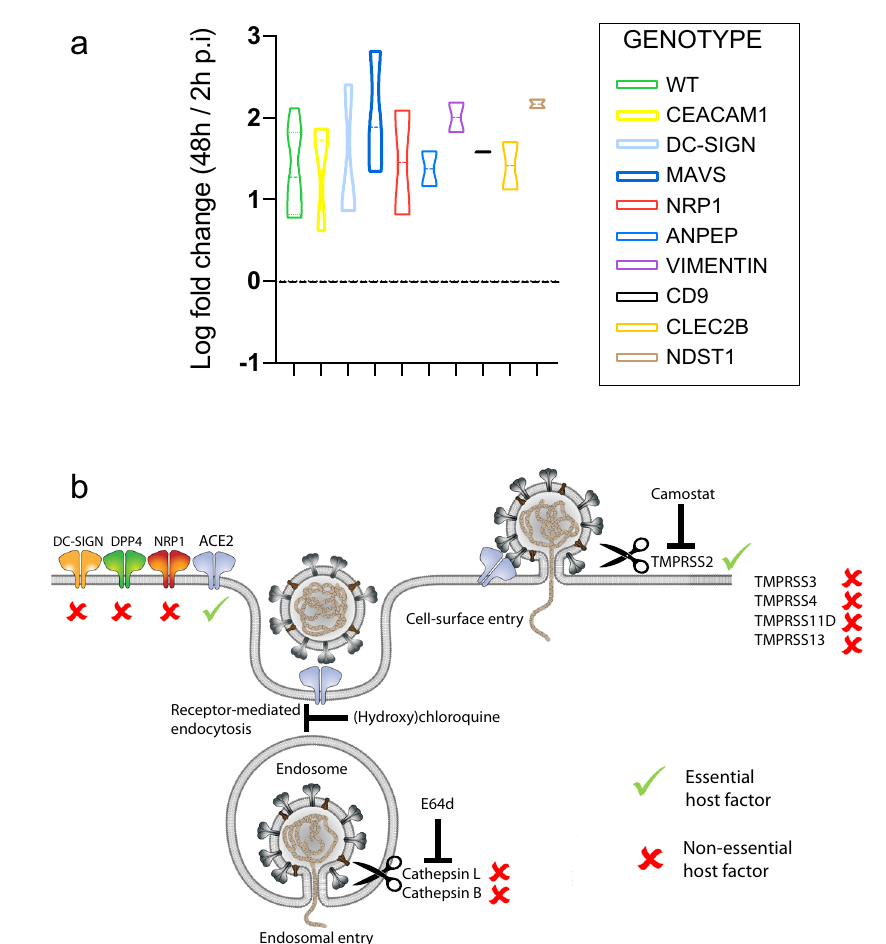
Fig. 5 Replication of SARS-CoV-2 in additional proposed host factors. a Violin plot displaying the Log10 ratio between the viral titer at 48 h compared to 2 h post infection (p.i.) quanti fi ed by qPCR targeting the E gene in wildtype organoids and cells harboring a loss-of-function of a single host factor. Graphs display the ratio between viral titer at 48 h compared to 2 h post infection (p.i.). The dotted line indicates a fold change of 1. Dotted lines within the violins indicate the median and quartiles. N = 7 for WT, N = 3 for CEACAM1, DC-SIGN and MAVS, and N = 2 for the remaining genes. The WT data is redisplayed from Fig. 4a. b Model of host entry receptors and proteases involved in the entry of SARS-CoV-2. Essential and non-essential host factors based on the phenotypes in IO mutants are